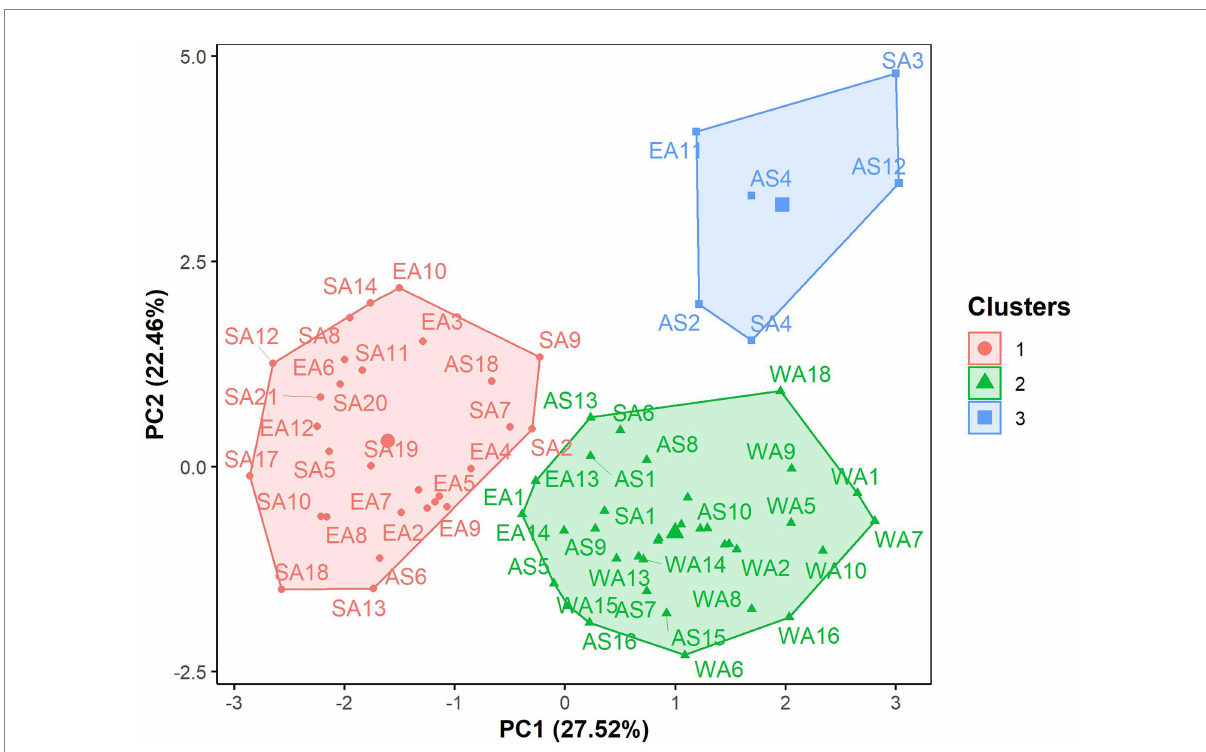
FIGURE 6 Factor map displaying the grouping pattern of 70 advanced lines of G. gynandra based on the hierarchical clustering on principal components analysis (HCPC). Cluster 1 ( n = 31), Cluster 2 ( n = 33) and Cluster 3 ( n = 6). AS: Asia; EA, Eastern Africa; SA, Southern Africa; WA, West